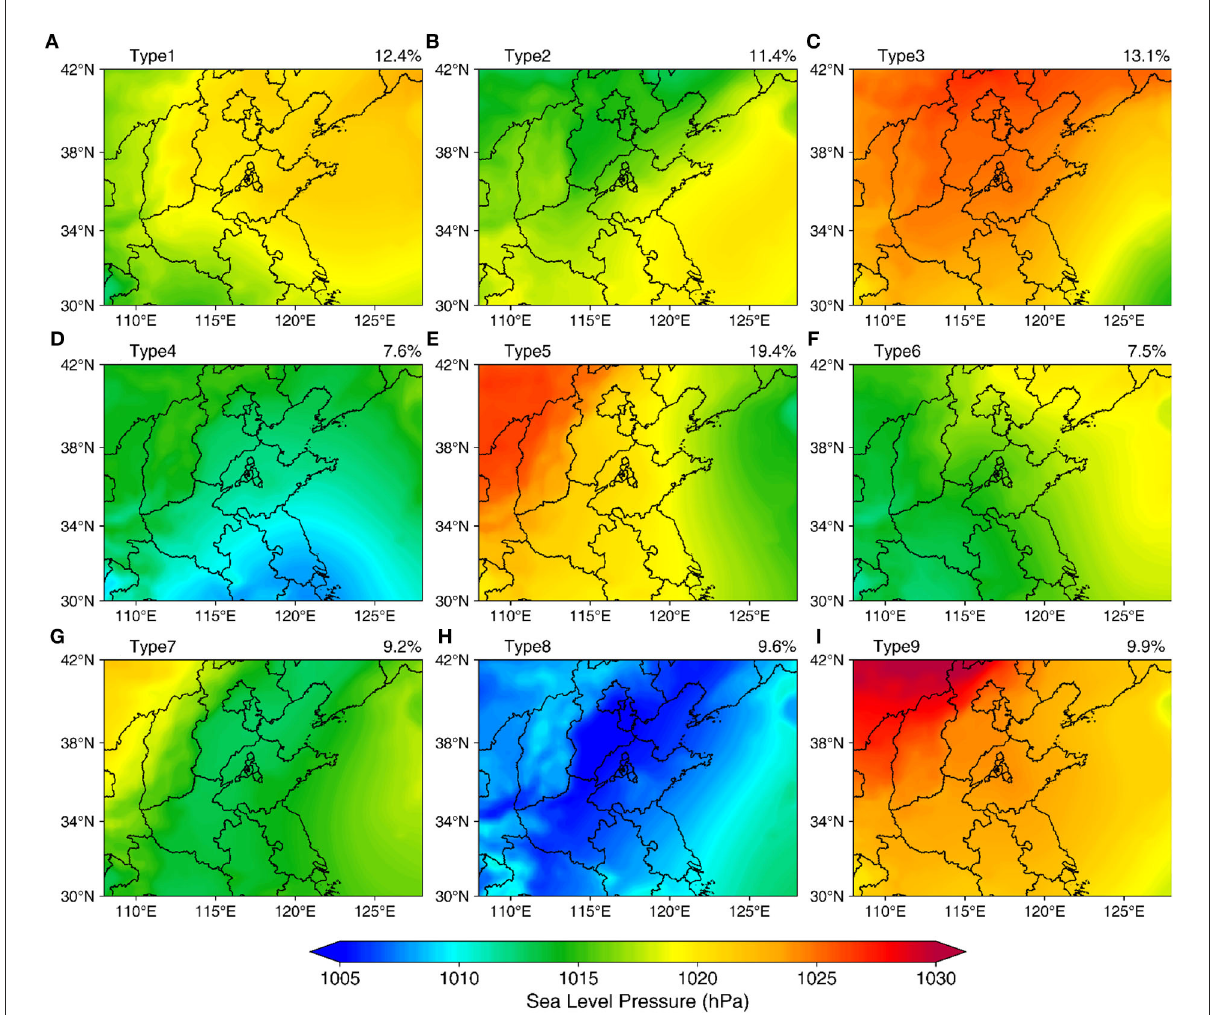
FIGURE5 Sea level pressure distribution in 9 synoptic patterns during 2013–2020 in North